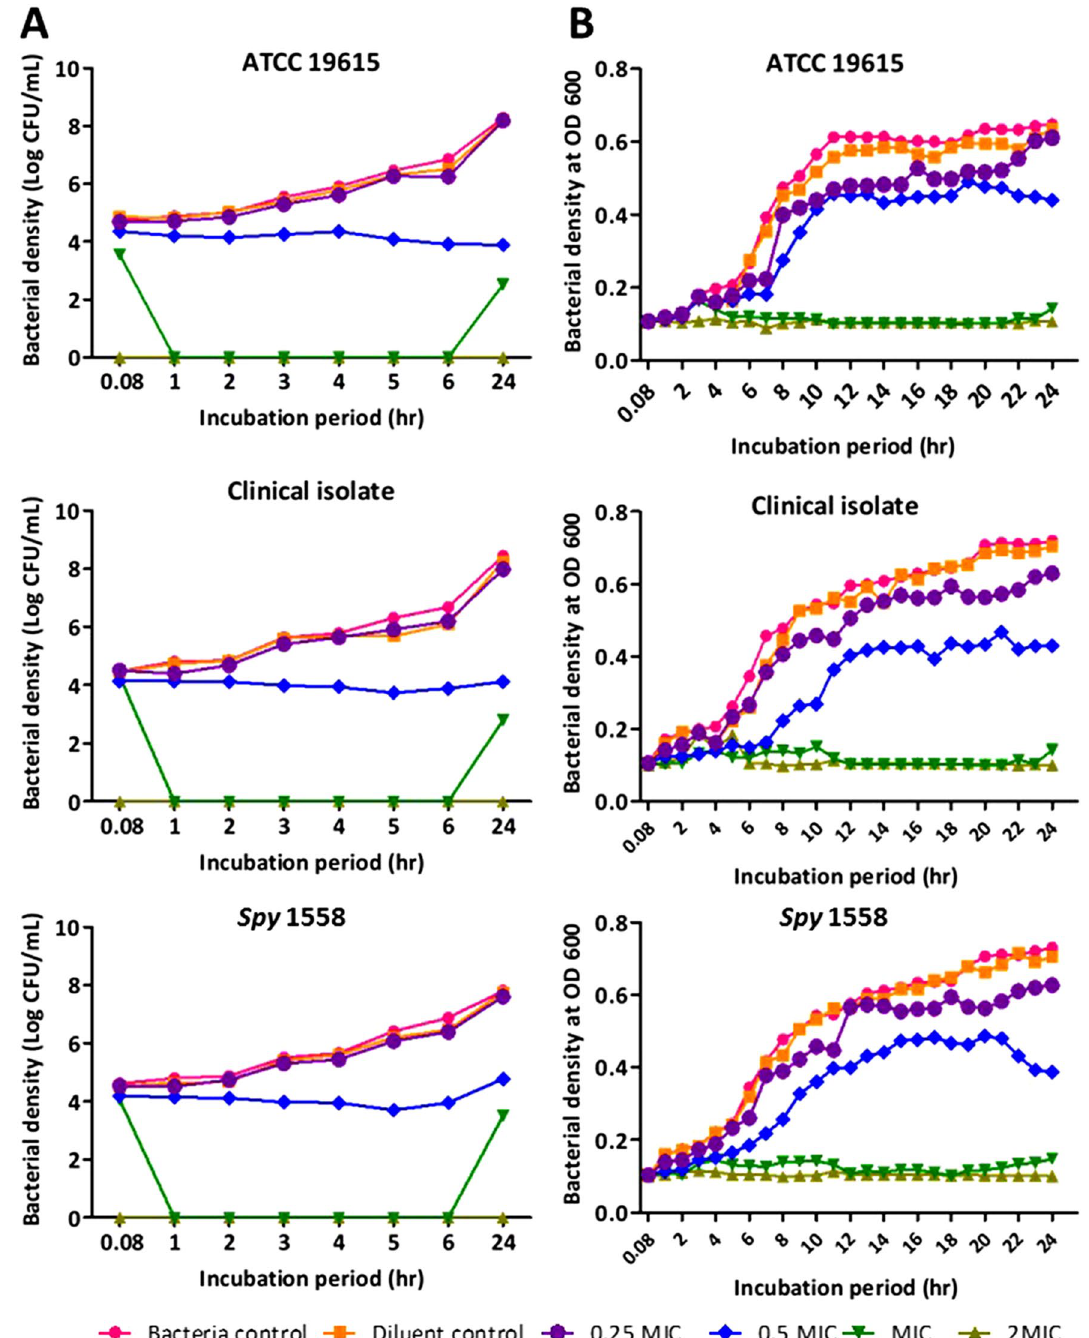
Figure 2. Carvacrol exerts concentration-dependent growth inhibition on Streptococcus pyogenes and an instantaneous bactericidal effect at 2 × MIC. Time-kill curve plots from ( A ) agar plate count method* and ( B ) spectrophotometric method** on the growth of Streptococcus pyogenes ATCC 19615, clinical isolate, and erythromycin-resistant, Spy 1558 in the presence of ¼ × MIC ½ × MIC, 1 × MIC, and 2 × MIC of carvacrol or 0.25% DMSO (diluent control) and no treatment (bacteria control). The bacteria and carvacrol solutions were prepared in BHI broth and were assessed for a period of 24 h at a 37 °C incubation period. *Cell growth/killing at 0.08, 1, 2, 3, 4, 5, 6, and 24 h incubation was measured by performing viable cell counts by dilution of cultures in saline solution (0.85% NaCl) and enumeration on BHI agar plates in duplicate. **The bacterial turbidity at OD = 600 nm was measured using a spectrophotometer in 1 h intervals over 24 h incubation period with different carvacrol concentrations or diluent in triplicate. Both methods were performed in three independent experiments. “0” in the scale represents “below the limit of